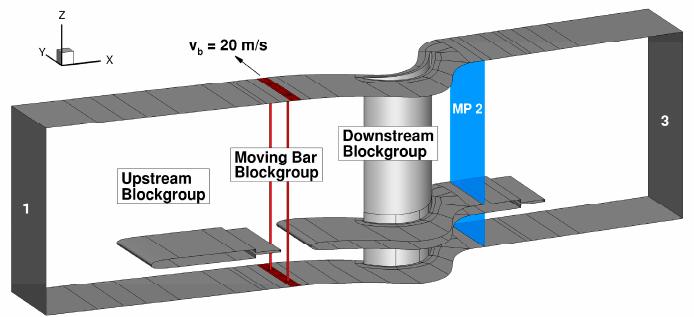
Figure 19. Block topology in the computational domain of the T106A cascade with an integrated two-part flat plate and a moving bar wake generator.